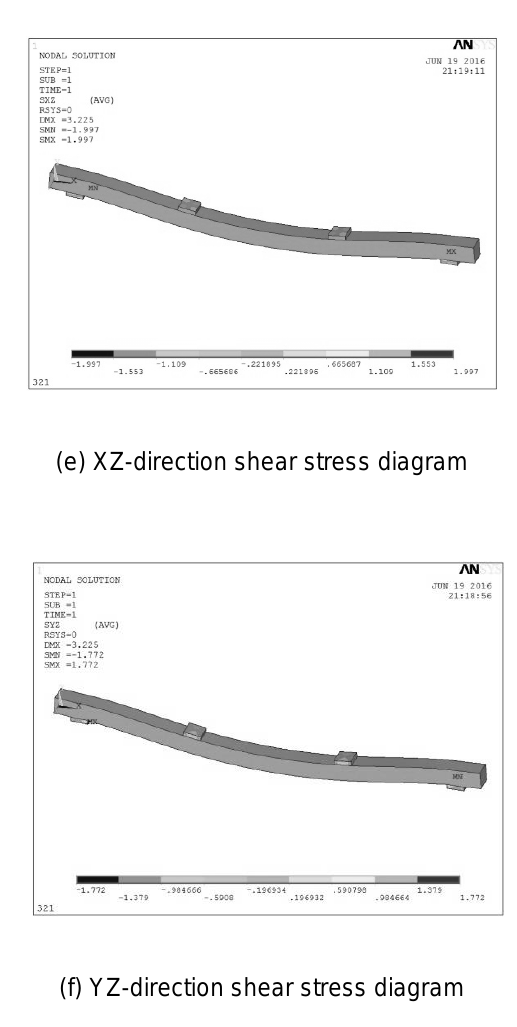
Figure 3. Figure stress larch wood beams in different